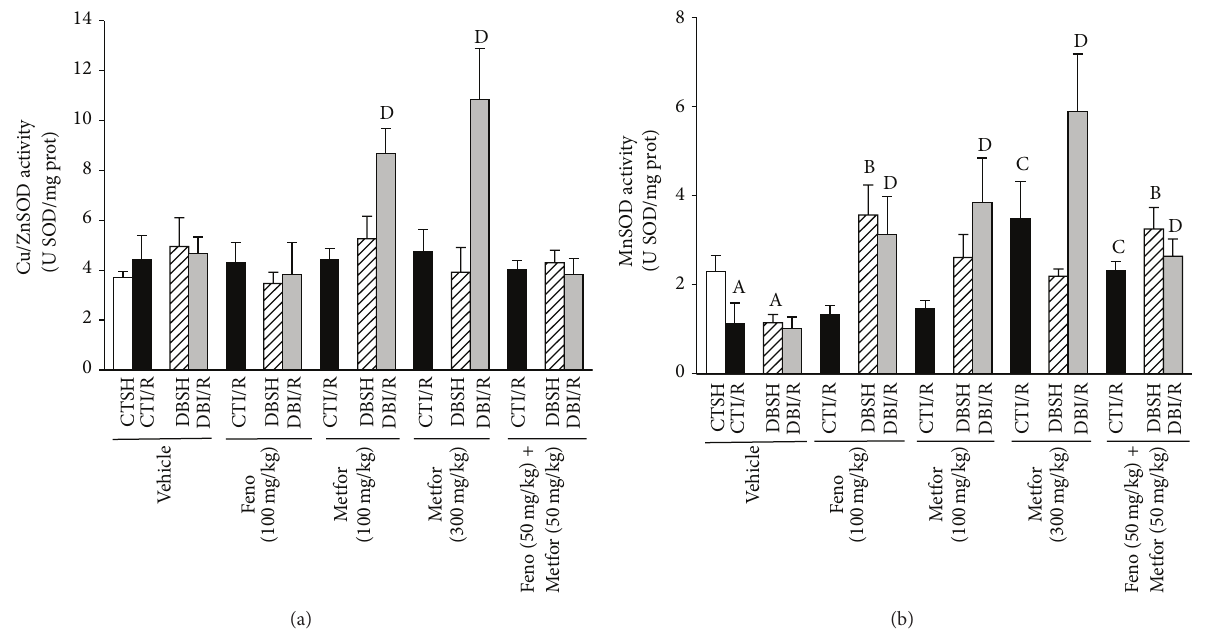
Figure 7: Effect of the treatments on Cu/ZnSOD and MnSOD activity, evaluated in ischemic left ventricle area from control- (CT-) and diabetic- (DB-) rats subjected to sham- (SH-) or ischemia/reperfusion- (I/R-) myocardial infarction and treated subchronically (14d) with either vehicle, fenofibrate (Feno, 100 mg/kg), metformin (Metfor, 100 or 300 mg/kg), or Feno (50mg/kg) + Metfor (50 mg/kg). (a) Cu/ZnSOD and (b) MnSOD activity ( 𝑛 = 4 –6 rats/group). A 𝑃 < 0.05 versus CTSH-Vehicle, B 𝑃 < 0.05 versus DBSH-Vehicle, C 𝑃 < 0.05 versus CTI/R- Vehicle, and D 𝑃 < 0.05 versus DBI/R-Vehicle two-way ANOVA followed by Duncan’s post hoc test. Data are presented as means ±